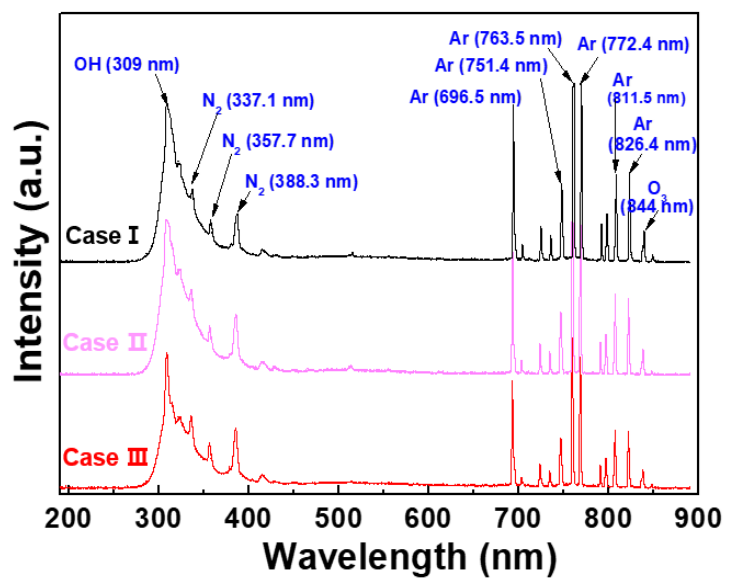
Figure 4. OES spectra of APPR under optimal conditions with respect to three electrode configurations of cases I, II, and III.